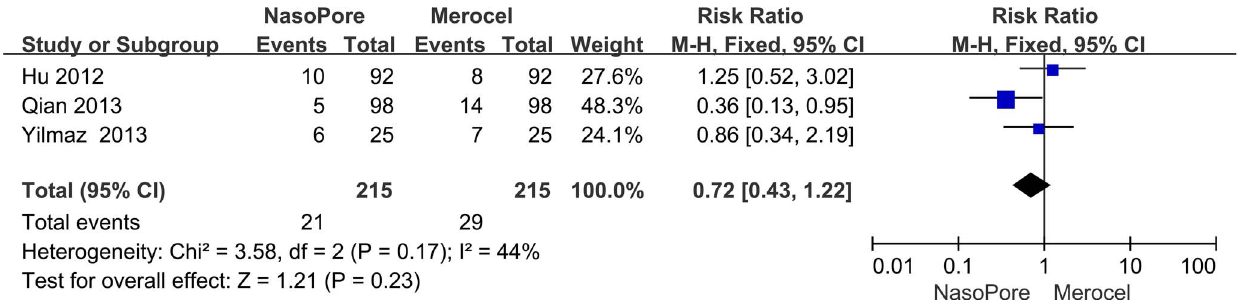
Figure 6. Forest plots of RR and 95% CI for nasal tissue adhesion.